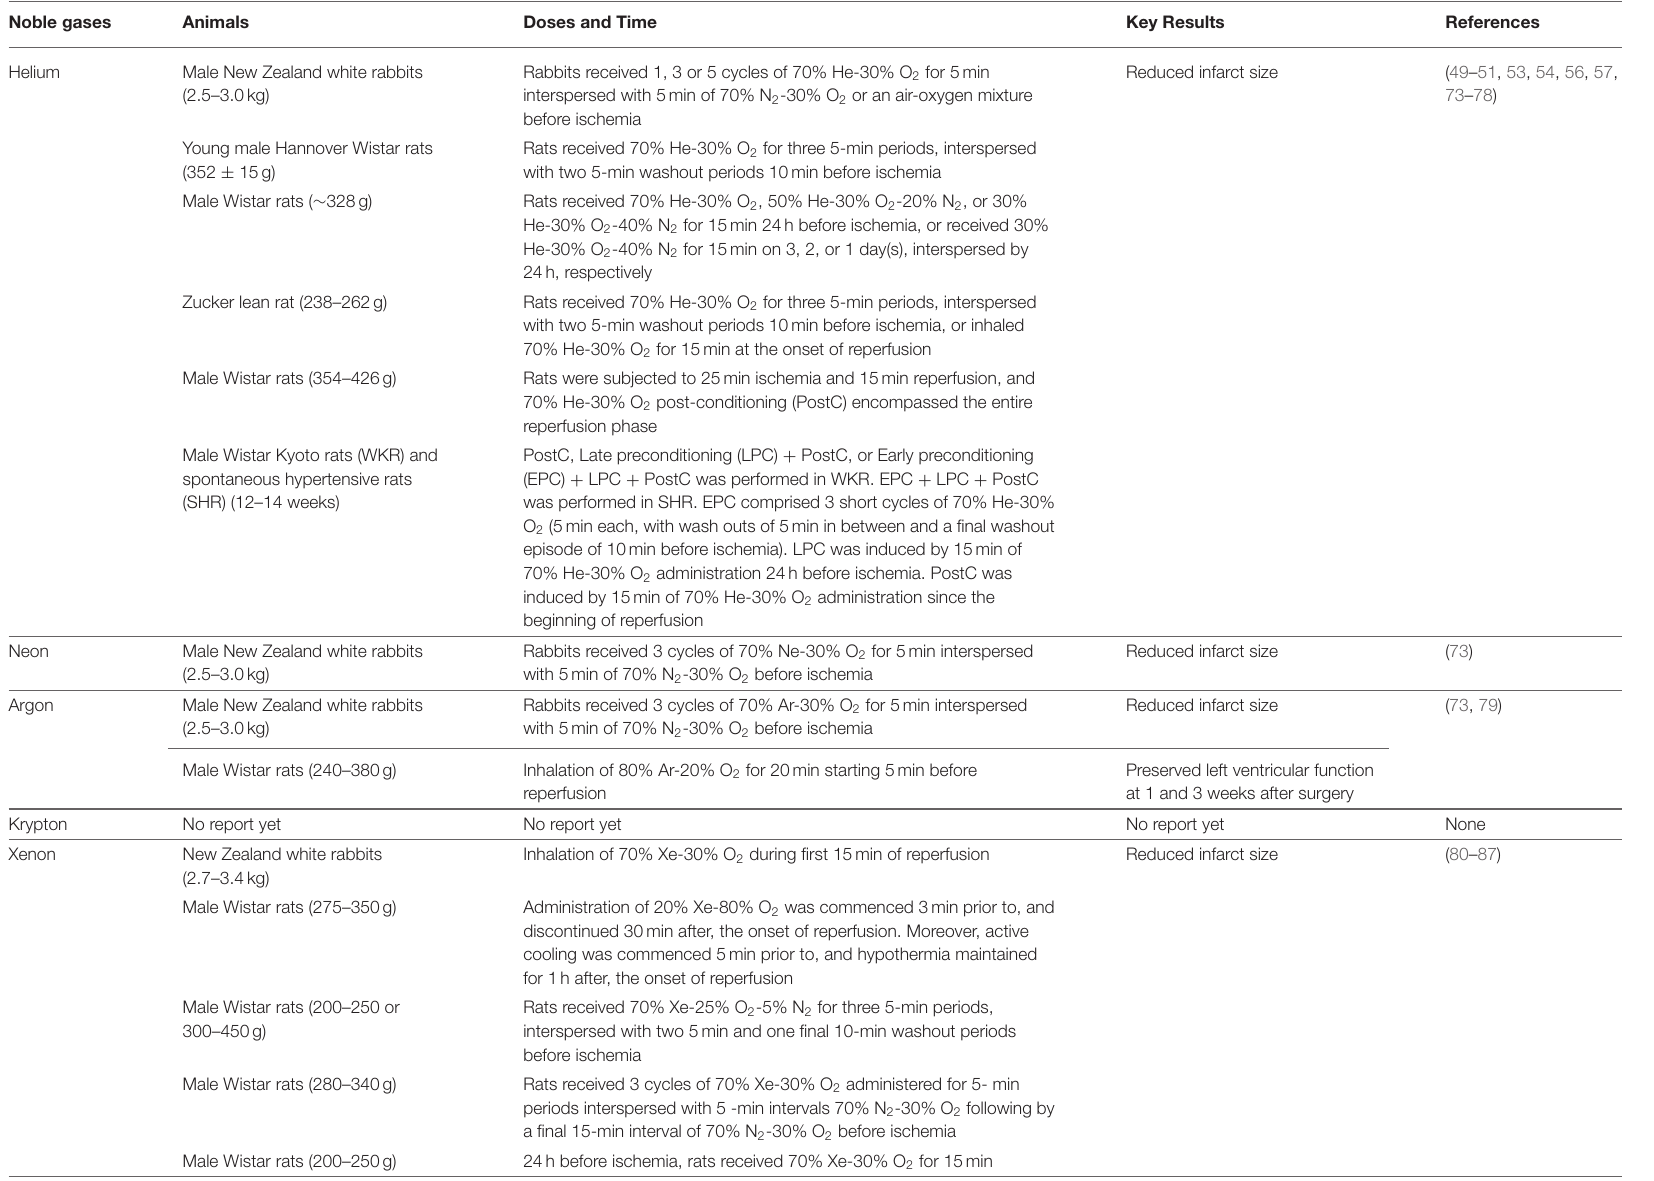
TABLE 1 | Noble gases alleviate myocardial ischemia/reperfusion (I/R) injury in animal models. Noble gases Animals Doses and Time